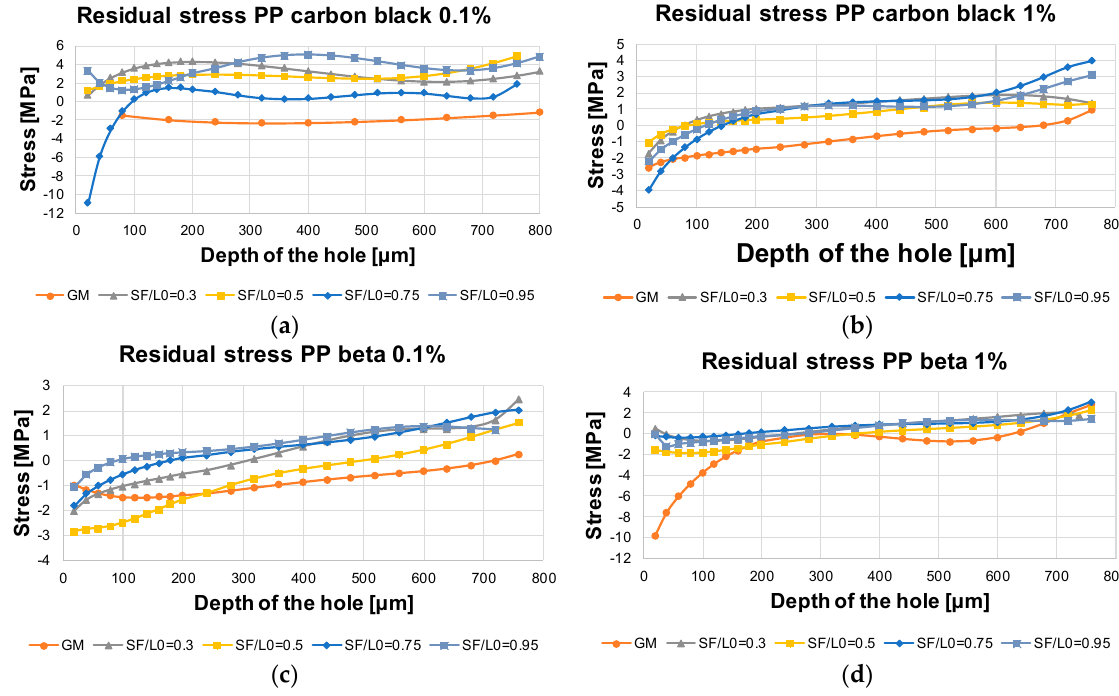
Figure 12. Residual stress results of the welded PP samples measured through hole drilling method ( a ) PP carbon black 0.1%, ( b ) PP carbon black 1%, ( c ) PP beta 0.1%, ( d ) PP beta 1%.